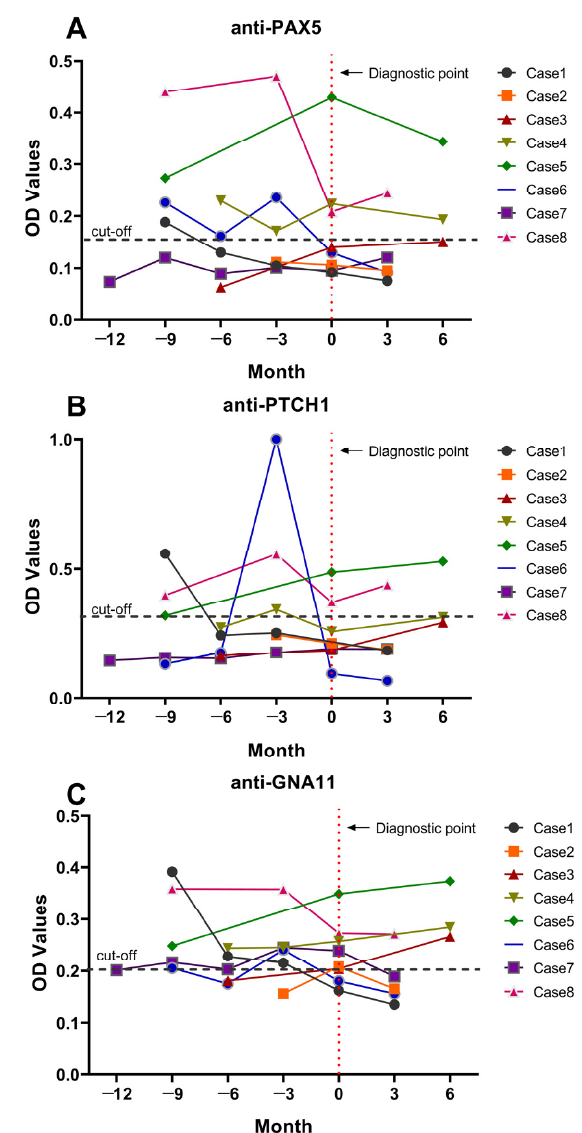
Figure 4. Levels of autoantibodies to PAX5 ( A ), PTCH1 ( B ), and GNA11 ( C ) in the sera of eight HCC patients who have been followed up before and after diagnosis of HCC for more than one year. Cut-off values of individual autoantibodies are shown by black dotted lines. The red dotted line indicates the time point where patients were clinically diagnosed with HCC.